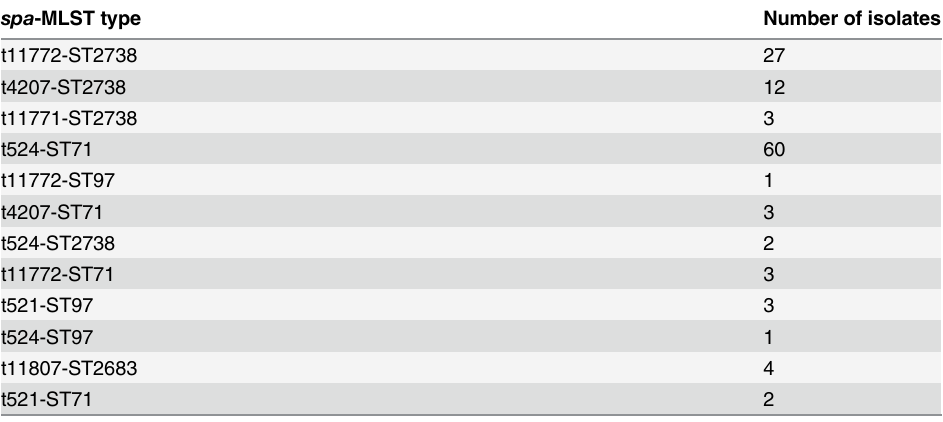
Table 2. Numbers of S . aureus isolates with different combinations of spa and MLST